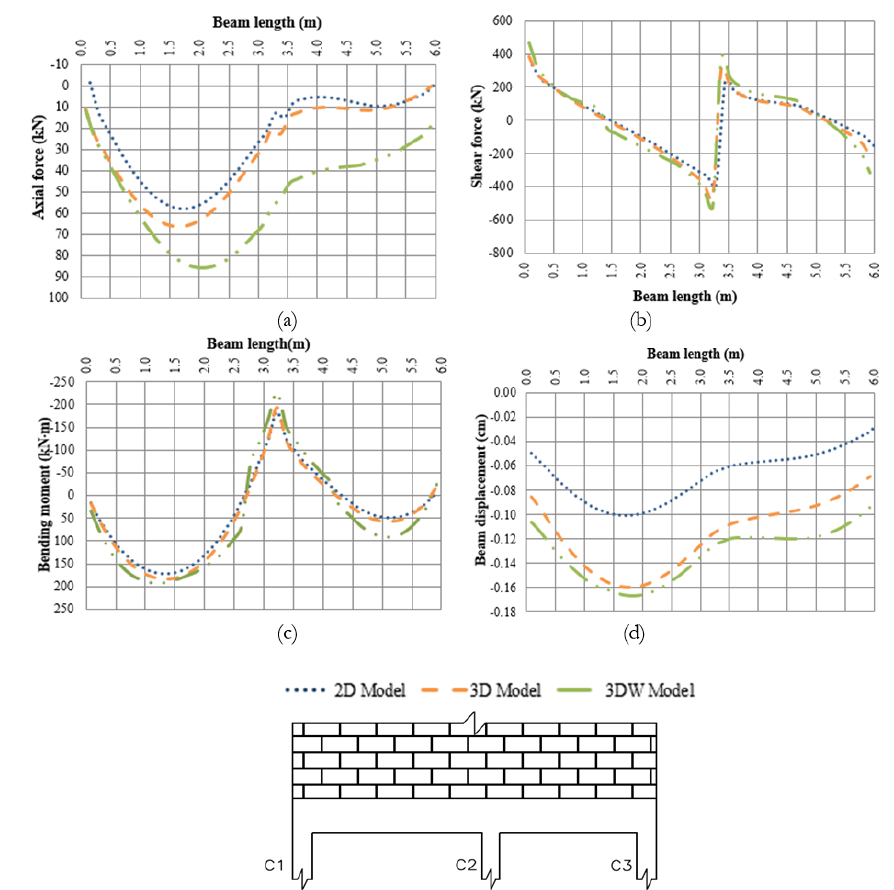
Figure 8. Forces on the support beam of wall 1: (a) Axial force; (b) Shear force; (c) Bending moment; (d) Vertical